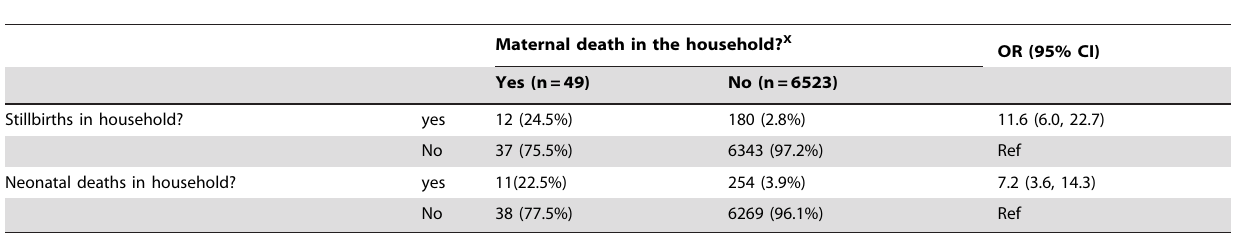
Table 7. Clustering of maternal and neonatal mortality and stillbirth in households, south-west Ethiopia